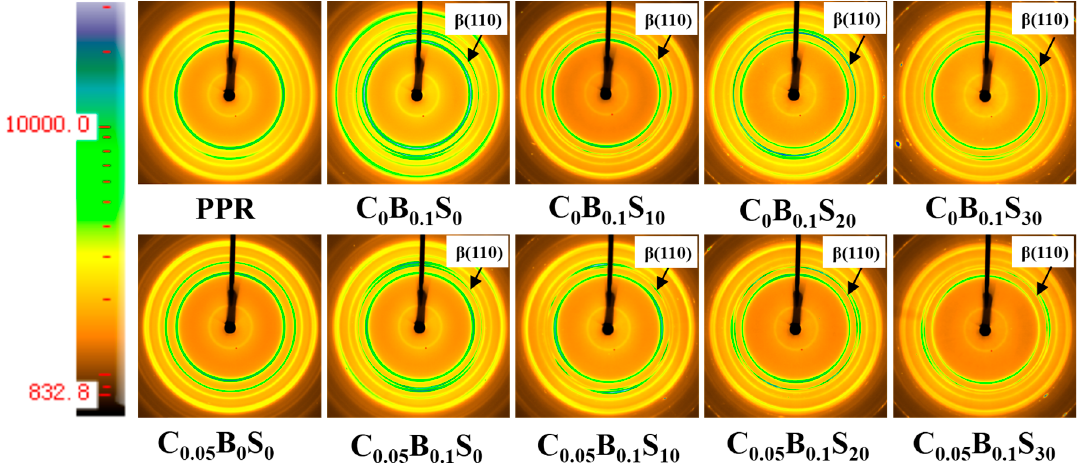
Figure 5. 2D-WAXD patterns of the PPR and its blends (Color bar represents Diffraction Intensity). Table 3. The crystallization data of PPR and its blends calculated from the WAXD.